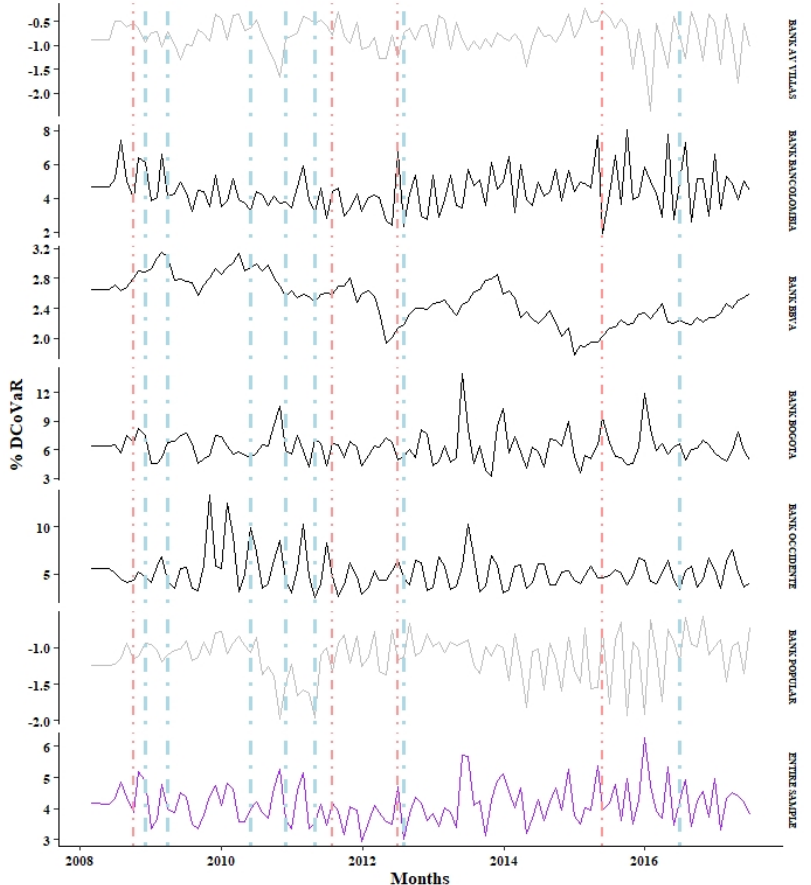
Figure 5. Monthly behavior of the DCoVaR systemic risk measure for both banks and the entire sample. Source: owner